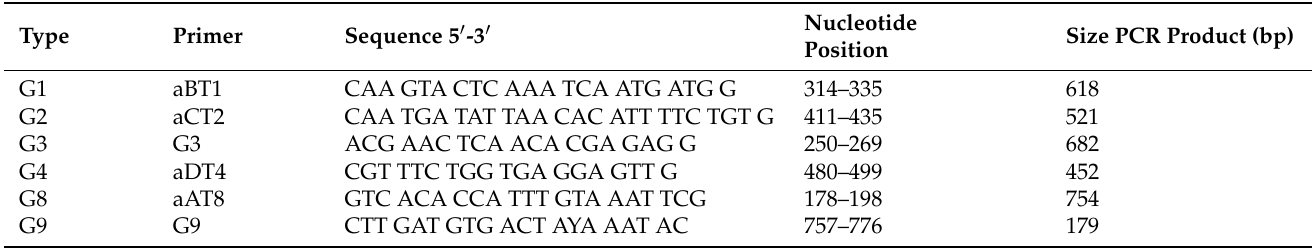
Table 3. G-Typing PCR